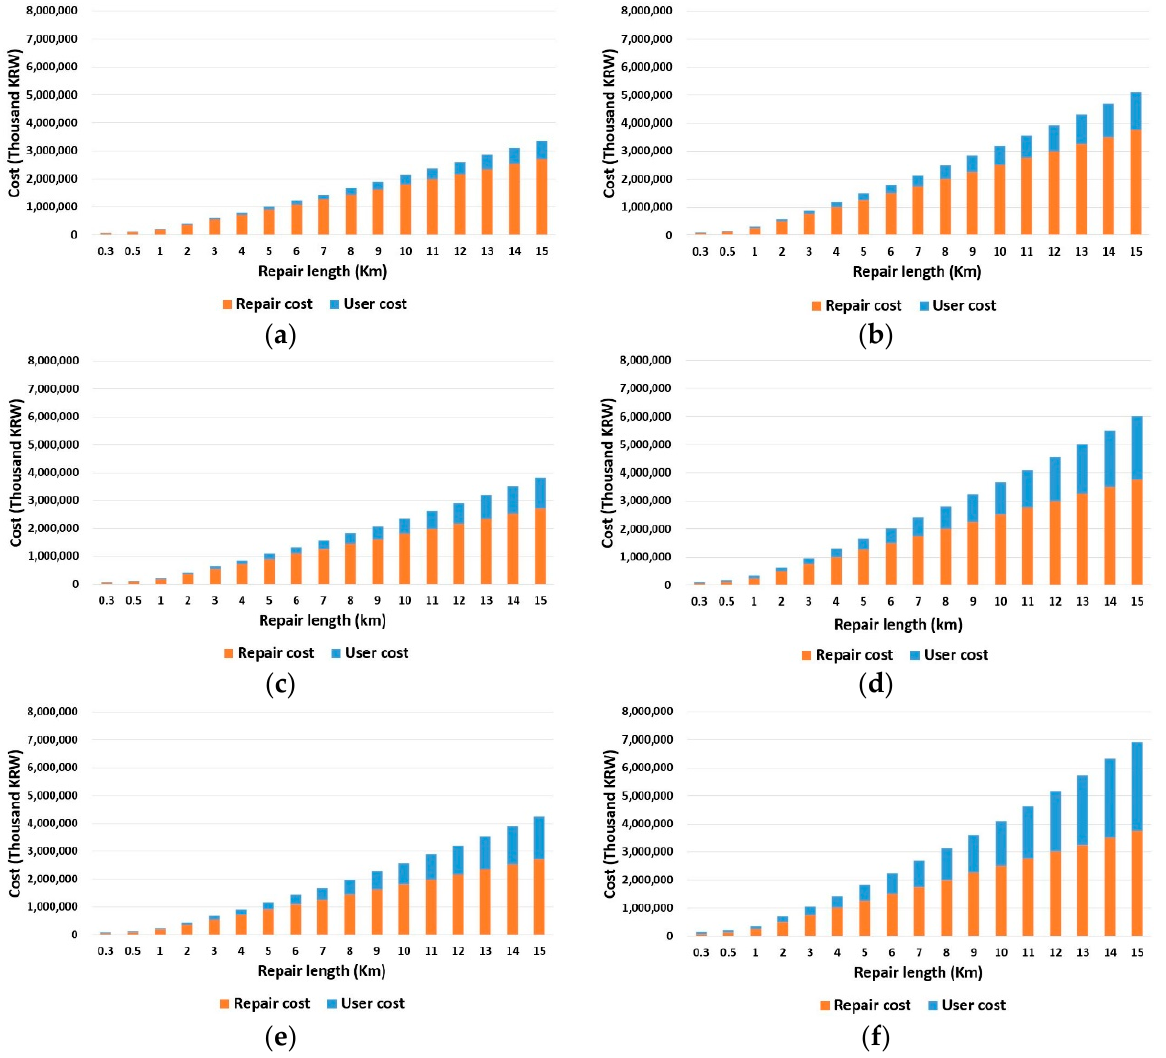
Figure 7. Total Overlay Construction Cost (4-lane). ( a ) Asphalt Overlay Total Construction Cost (4-lane, shoulder road X, 15,000 AADT). ( b ) Concrete Overlay Total Construction Cost (4-lane, shoulder road X, 15,000 AADT). ( c ) Asphalt Overlay Total Construction Cost (4-lane, shoulder X, 25,000 AADT). ( d ) Concrete Overlay Total Construction Cost (4-lane, shoulder X, 25,000 AADT). ( e ) Asphalt Overlay Total Construction Cost (4-lane, shoulder road X, 35,000 AADT). ( f ) Concrete Overlay Total Construction Cost (4-lane, shoulder road X, 35,000